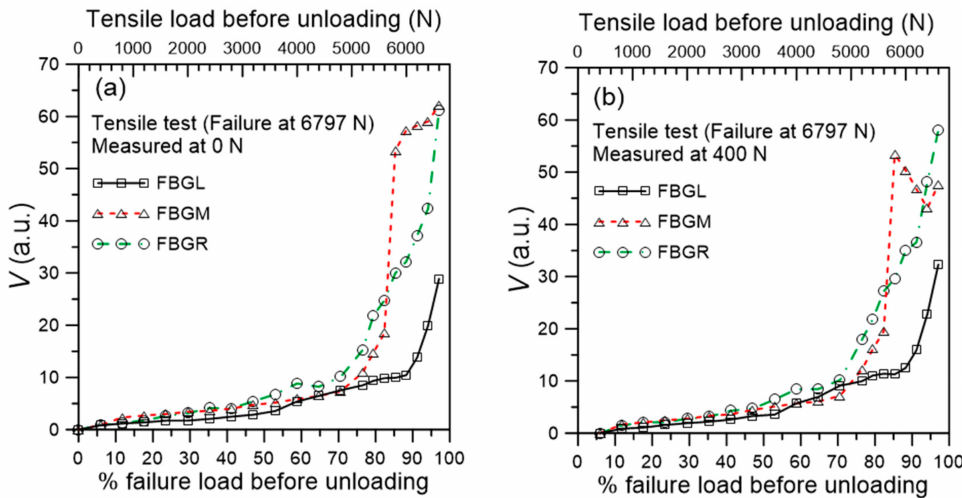
Figure 8. Evolution of the V values of FBG spectra unloaded from various tensile loading measured at: ( a ) 0 N; ( b ) 400